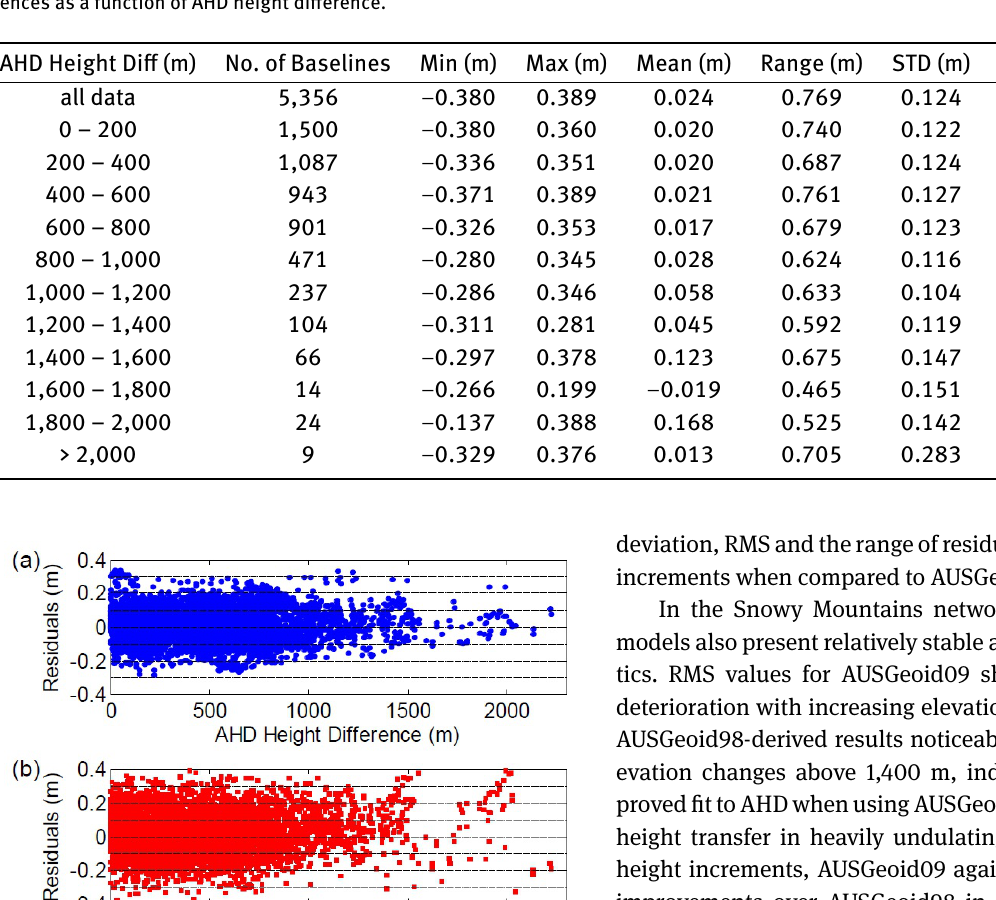
Table 4: Snowy Mountains verification: Descriptive statistics of the residuals between AUSGeoid98-derived and oflcial AHD height differ- ences as a function of AHD height difference.